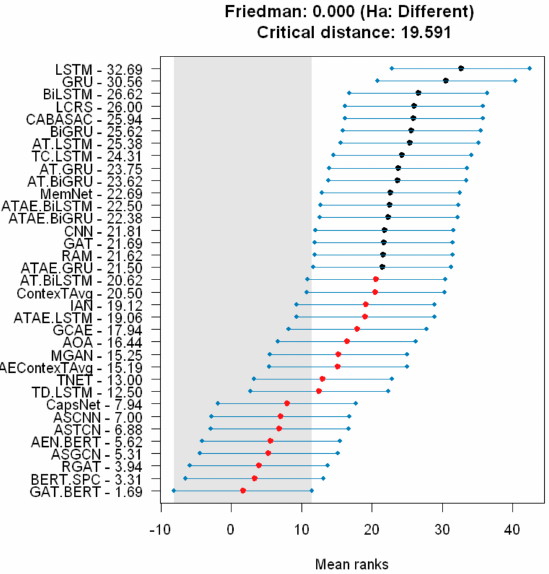
Figure 6. Nemenyi test Critical Distance diagram for 35 deep learning methods for Accuracy.